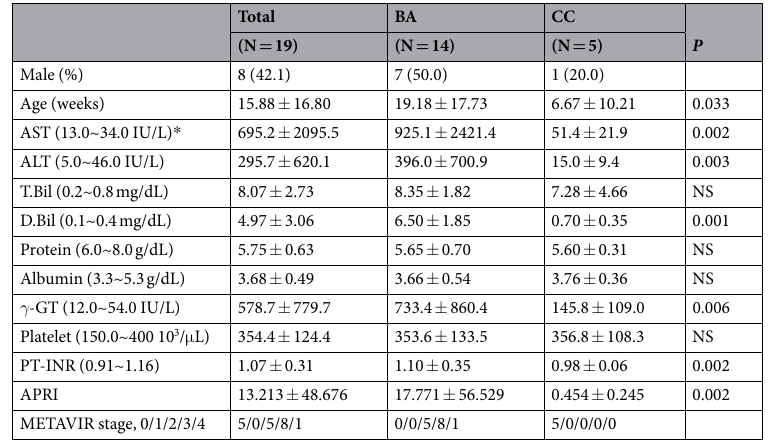
Table 1. Comparison of clinical and biochemical characteristics of all liver diseases between BA and CC patients. All data show mean ± SD. AST = aspartate aminotransferase; ALT = alanine aminotransferase; T.Bil = total value bilirubin; D.Bil = direct bilirubin; γ -GT = gamma-glutamyl transpeptidase; PT- INR = prothrombine time-international normalized ratio; APRI = AST to platelet ratio index; BA = biliary atresia; CC = choledochal cysts.